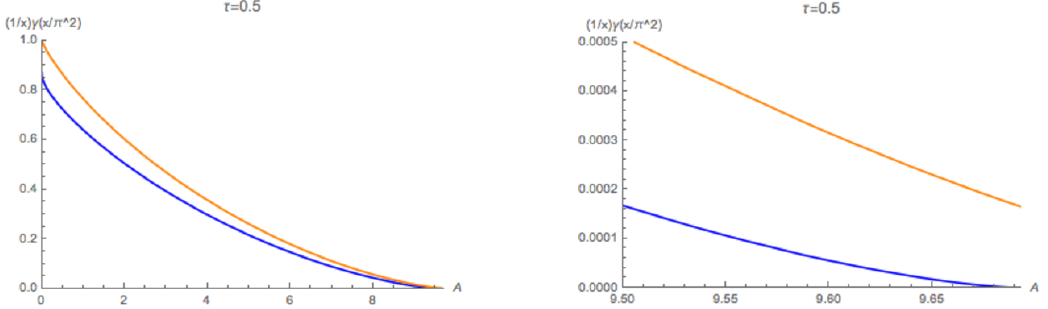
(cid:0) x (cid:1) for the deformed (blue) and undeformed (cid:25) 2 (cid:0) x (cid:1) (cid:13) for the deformed (blue) x (cid:25) 2